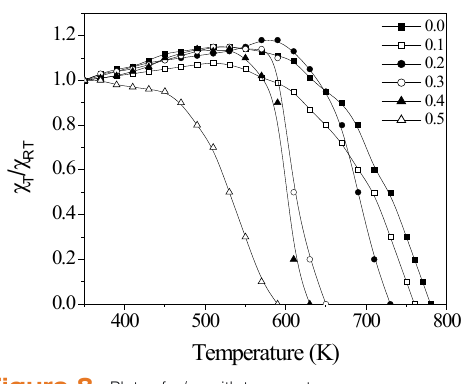
/ with temperature. χ T χ RT